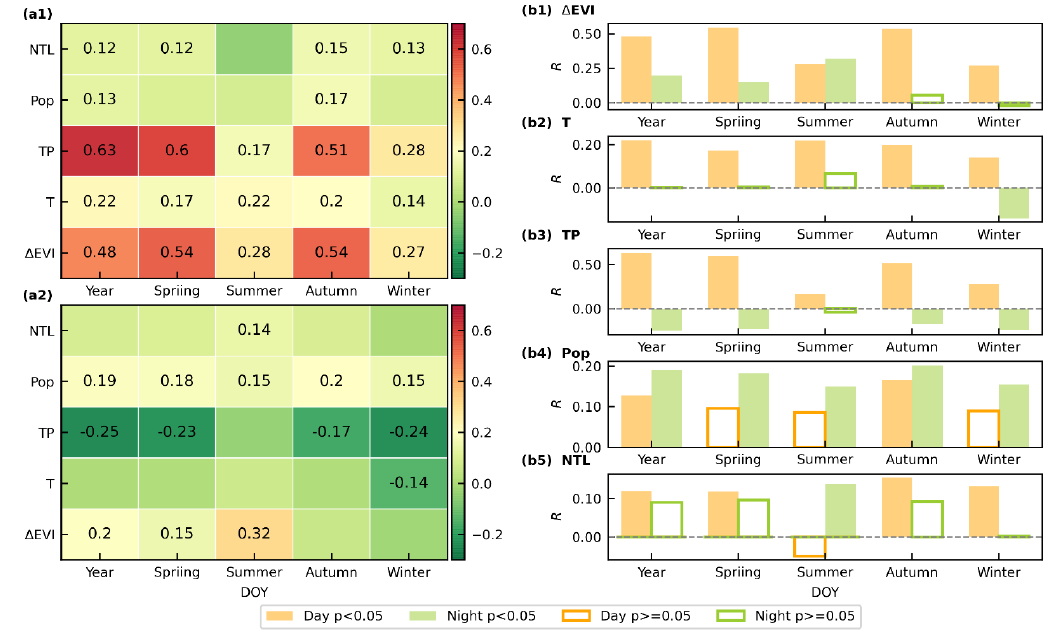
Figure 10. Relationship between SUHIF and potential factors in terms of annual and seasonal scales. The heat maps represent their correlation at daytime ( a1 ) and nighttime ( a2 ). The bar charts ( b ) show a diurnal contrast of their relationship in terms of each factor (( b1 ) for ΔEVI, ( b2 ) for T, ( b3 ) for TP, ( b4 ) for Pop, ( b5 ) for NTL). To make the results clear, the correlation with p -values less than 0.05 are labeled in the heat maps.